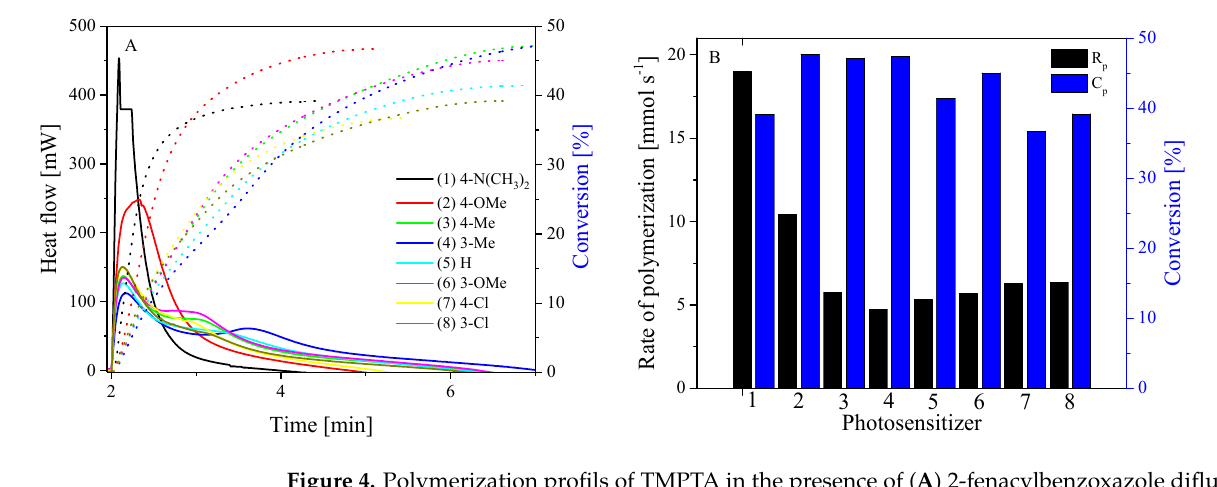
Figure 4. Polymerization profils of TMPTA in the presence of ( A ) 2-fenacylbenzoxazole difluorobo- ranes/Pyr (1 × 10 − 3 M/1 × 10 − 2 M), ( B ) polymerization of TMPTA in the presence of BODIPY dyes/ N -methoxy-4-phenylpyridinium tetrafluoroborate under irradiation with UV-Vis light. Light intensity: 50 mW cm − 2 (solid line denotes data of rate of polymerization; dash line–conversion of monomer).